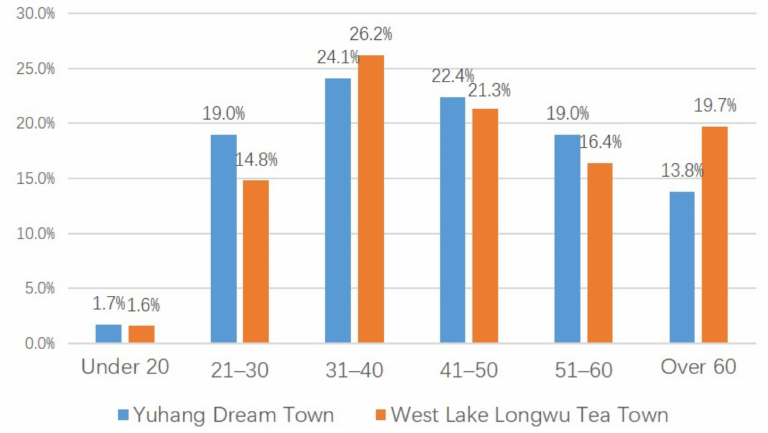
Figure 5. Age distribution of respondents (source: authors).